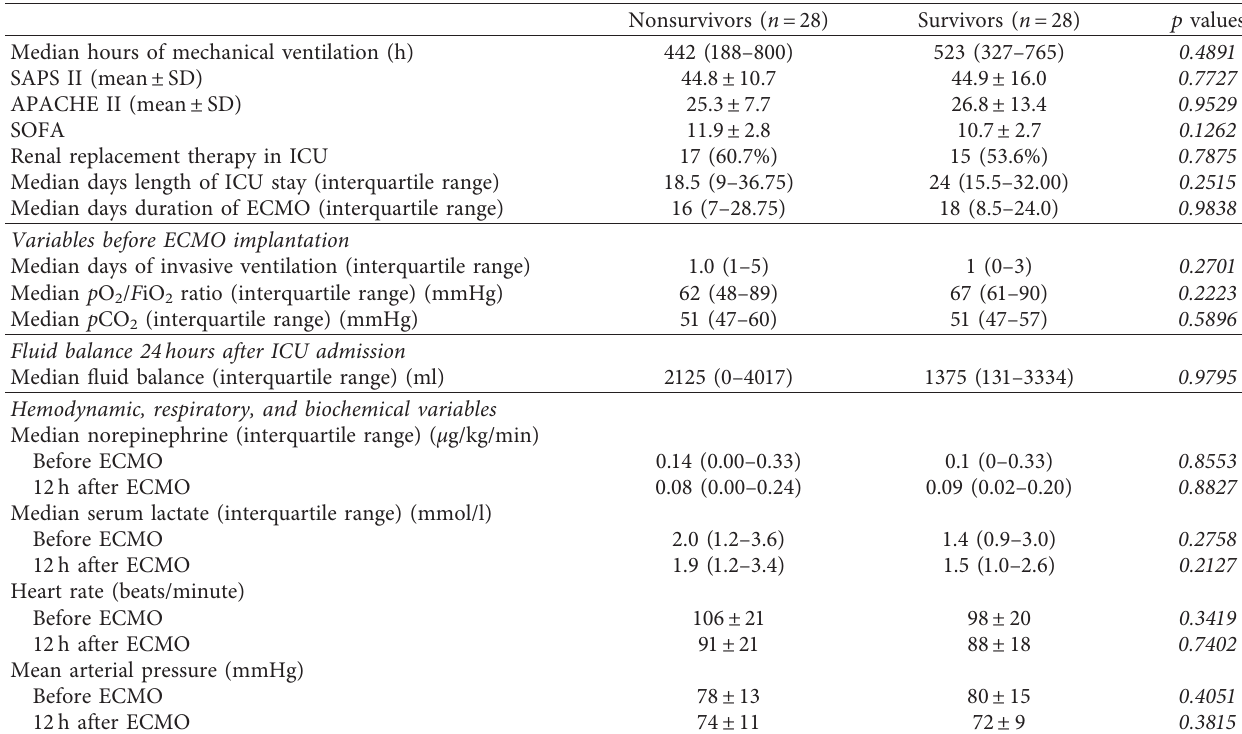
Table 2: ICU patient